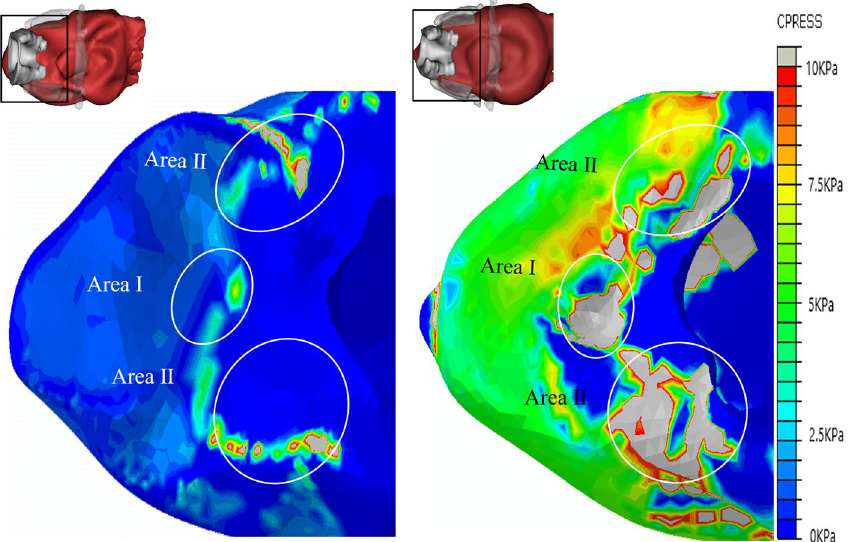
Figure 7. The pressure on hypopharyngeal mucosa of PB-LMA50 (left) and PB-LMA100 (right). Area I shows the impact of the cricoid cartilage (Bone I) pressing the mucosa from the top; Area II shows the impact of the thyroid cartilage (Bone II) squeezing the mucosa from the sides. The peak MP magnitudes are 7.5 kPa (Area I, 9 mmHg), 49.9 kPa (Area I, 45 mmHg), 26.1 kPa (Area II, 9mmHg) and 114.7 kPa (Area II, 45 mmHg),